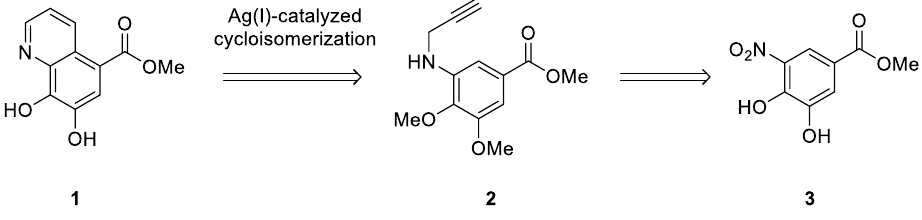
Figure 2. Retrosynthetic analysis for aaptoline A ( 1 ).